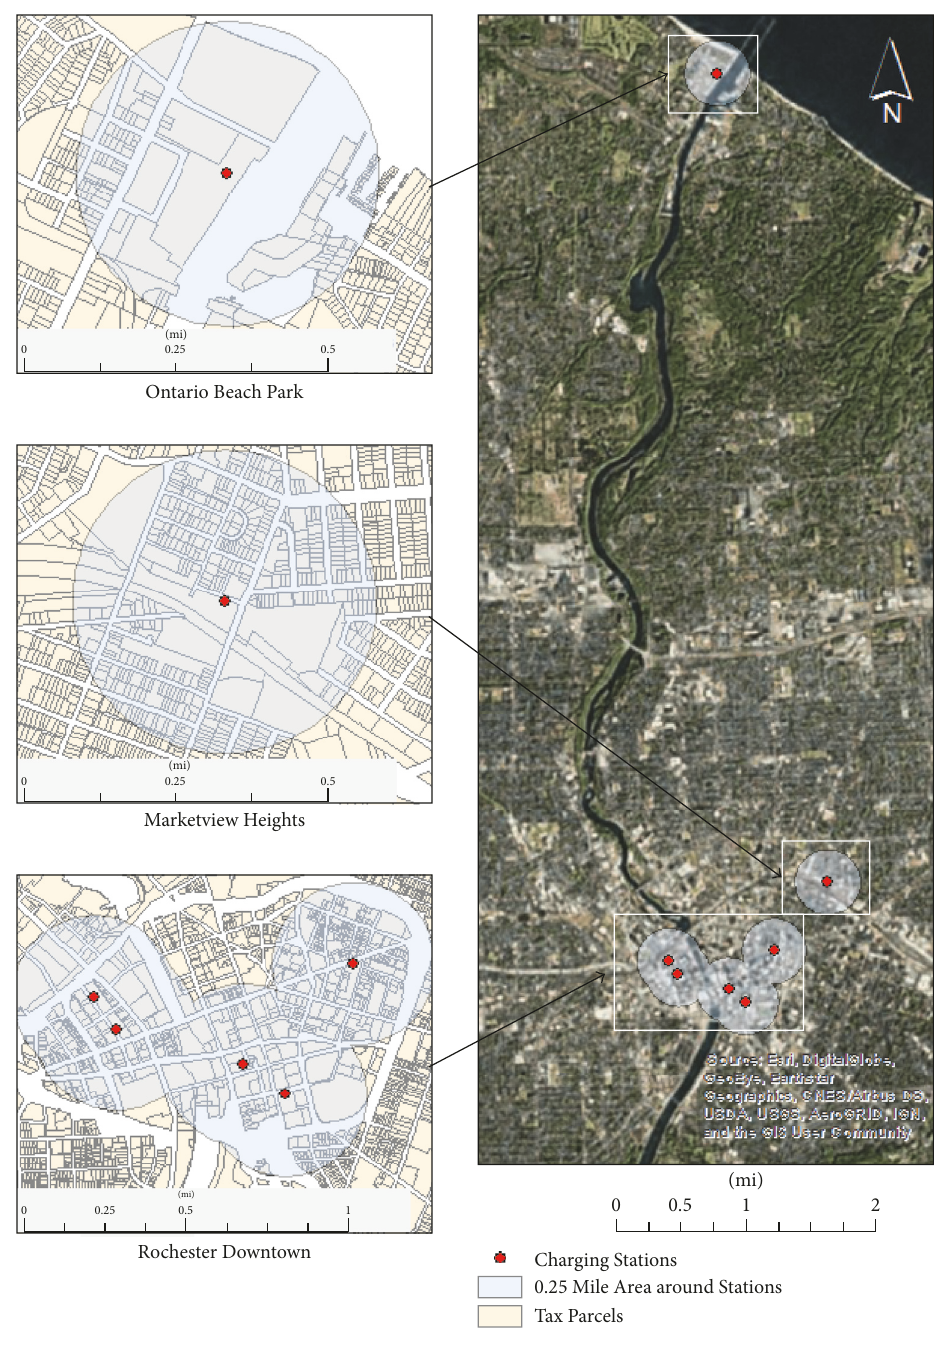
Figure 1: Location of charging stations in the City of Rochester (with 1/4 mile